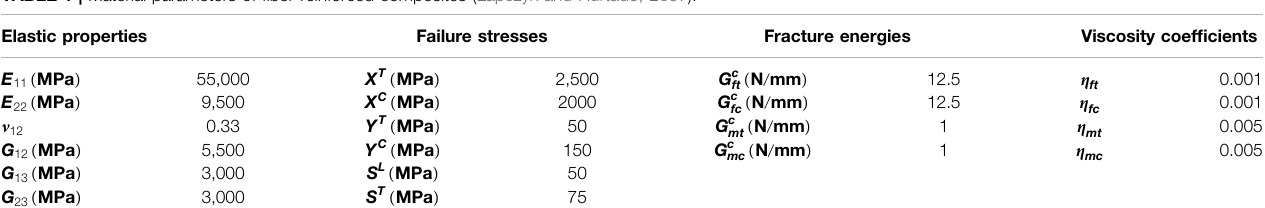
TABLE 1 | Material parameters of fi ber-reinforced composites (Lapczyk and Hurtado, 2007). Elastic